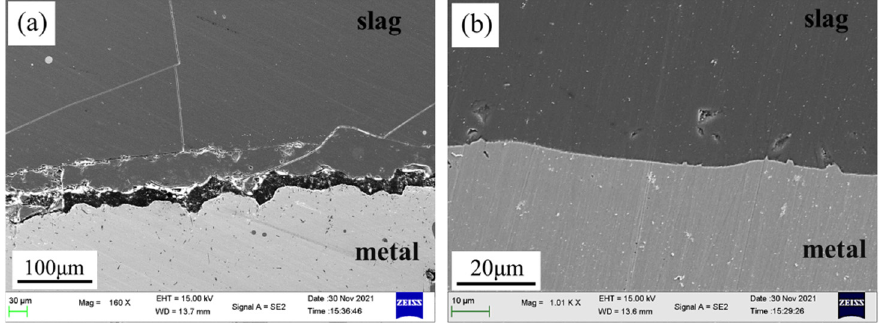
Figure 5. The interface morphology between pure Fe and high SiO 2 flux after reacted at 1873 K for ( a ) 5 min and ( b ) 7 min, respectively.